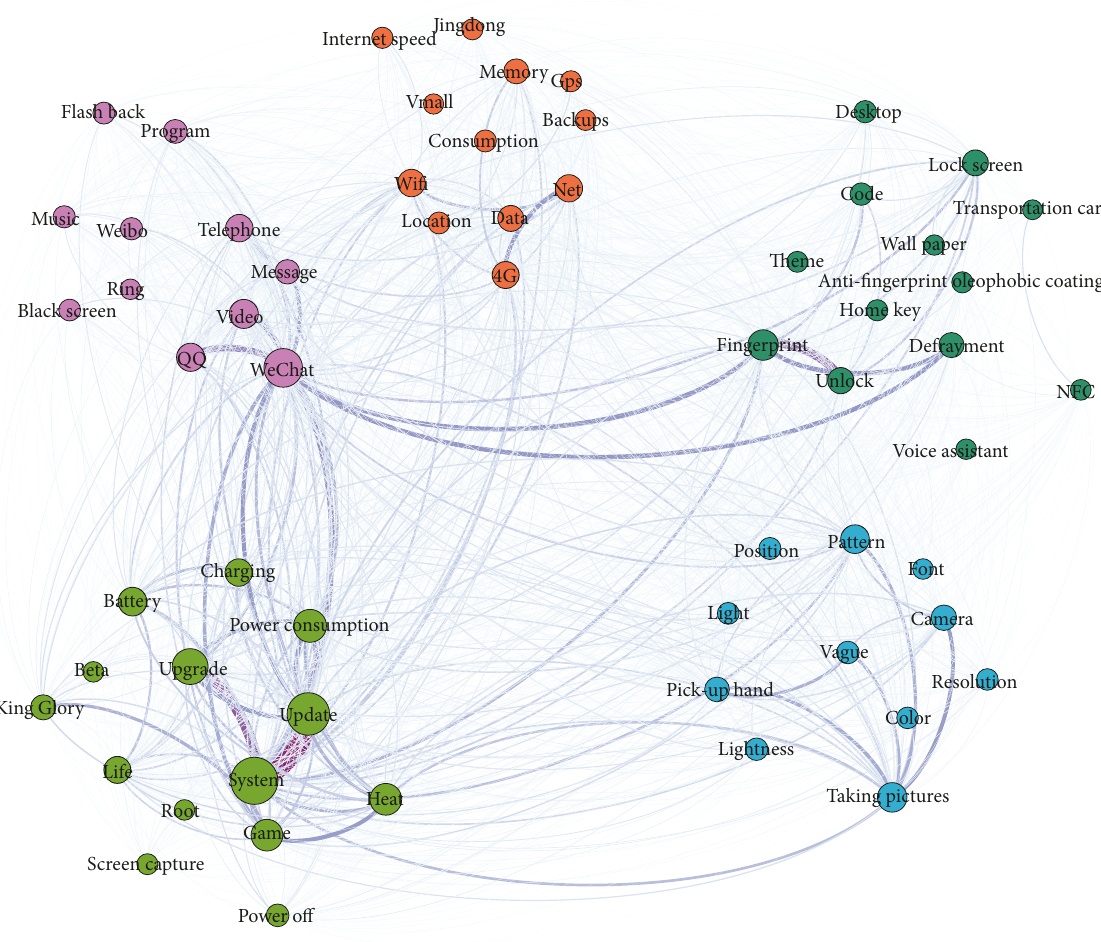
Figure 3: OUG interaction